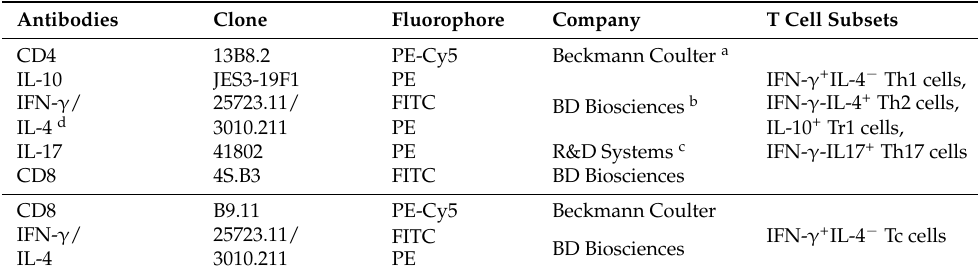
Table 2. The combination of monoclonal antibodies used for flow cytometry analysis of Th and Tc cell